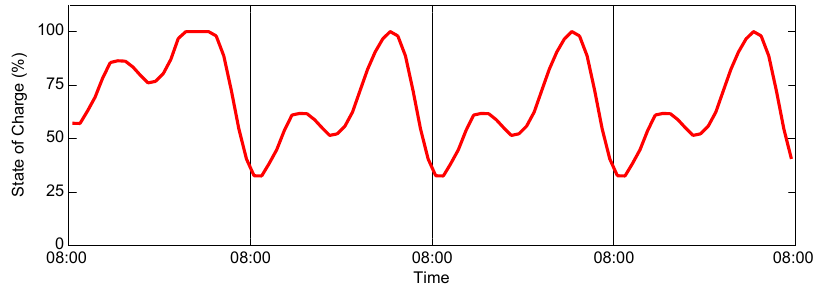
Figure 8. Battery SOC fluctuation without considering seasonal